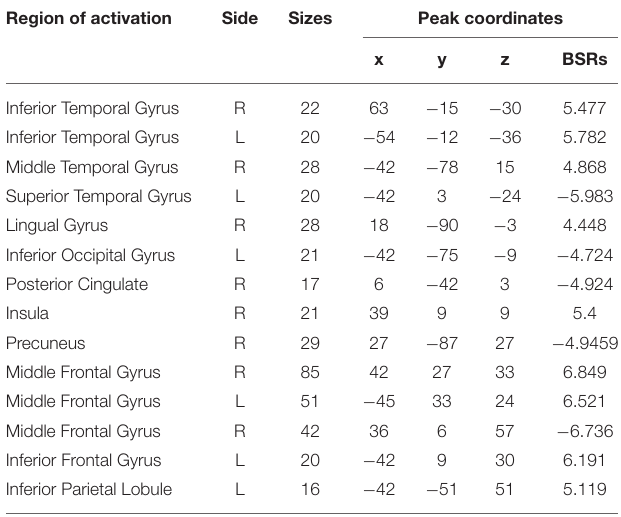
TABLE 3 | The brain regions that have reliability contribution to behavior-brain covariance in LV 1. Region of activation